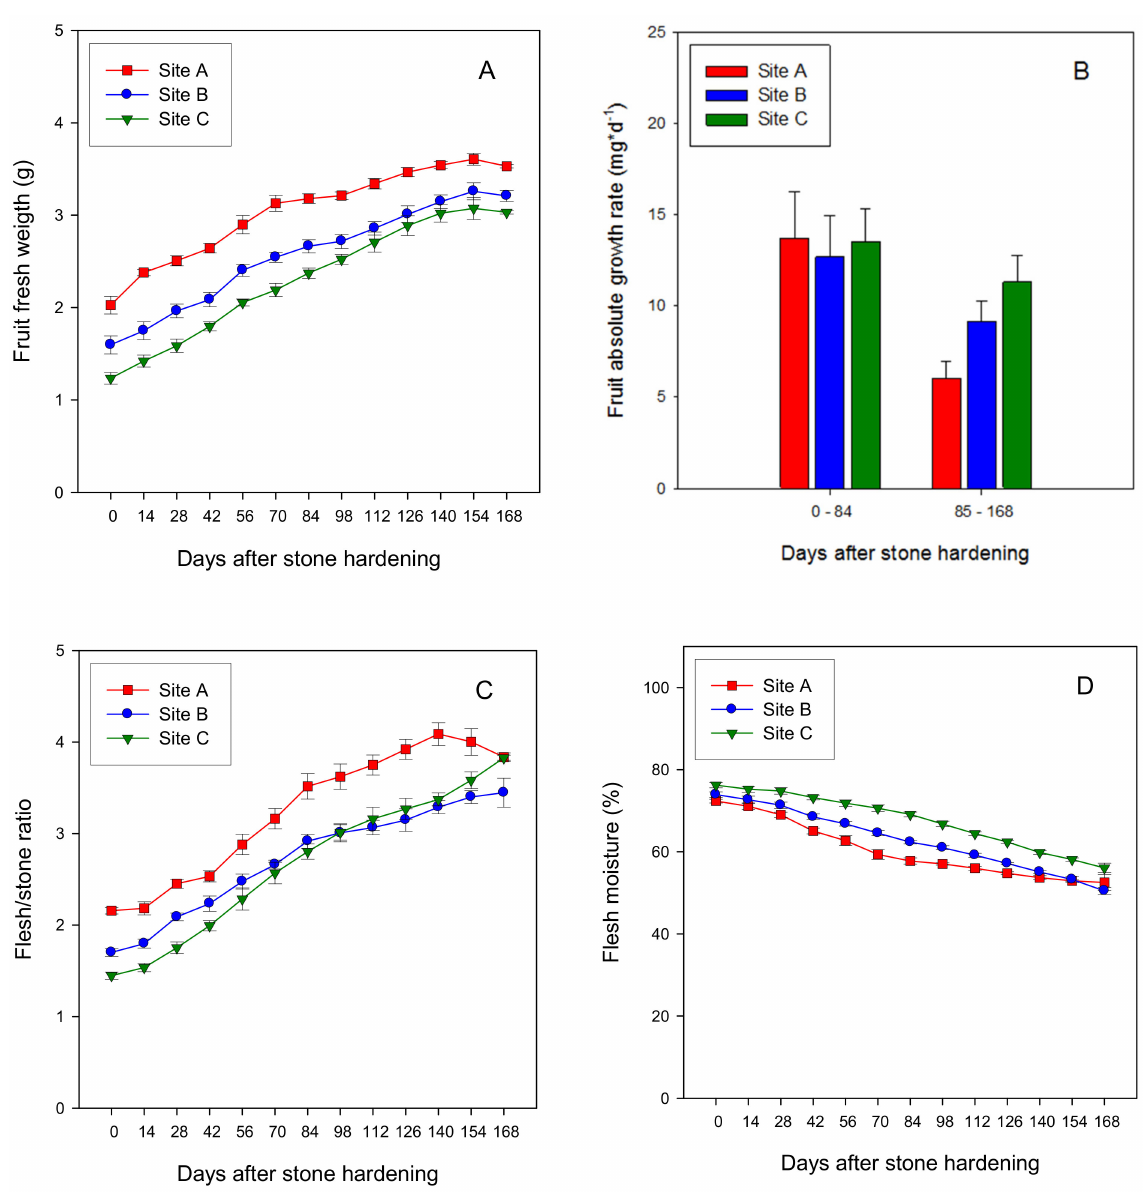
Figure 3. Seasonal changes in fruit fresh weight ( A ), fruit absolute growth rate ( B ), flesh/stone ratio ( C ) and flesh moisture ( D ) during development and ripening process of Carolea olive cultivar grown at three different sites. Data are mean ± standard error (years 2013, 2014 and